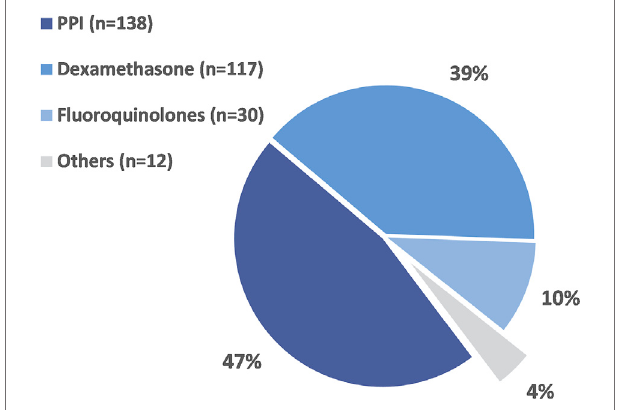
FIGURE 1 | The proportion of different drug classes associated with potentially hazardous DDIs in the studied